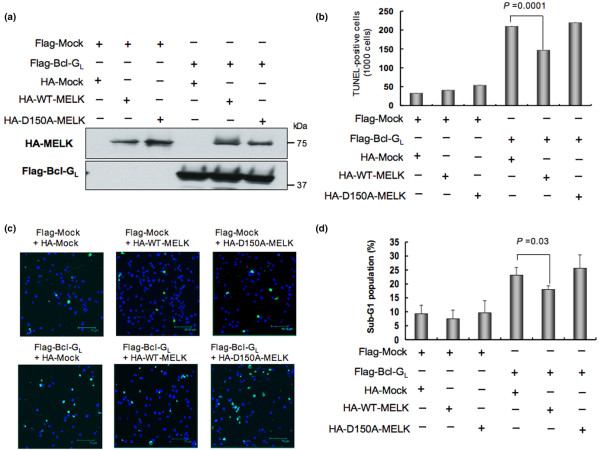
MELK involvement in the apoptosis cascade through Bcl-GL. HA (hemagglutinin)-tagged MELK (HA-wild-type (WT)-MELK or HA-kinase-dead (D150A)-MELK) and Flag-tagged Bcl-GL (Flag-Bcl-GL) expression vectors were co-transfected into COS7 cells for 24 hours. (a) The expression of MELK and Bcl-GL proteins in the co-transfected cells were examined by western blot analysis. (b) TUNEL assays after transfection with pCAGGSnHC (HA-Mock), pCAGGSn3FH (Flag-Mock), HA-tagged MELK (WT and D150A), Flag-tagged Bcl-GL expression vectors, and combinations of these. Apoptotic cells were measured by counting of TUNEL staining (means ± standard deviation, n = 3; P = 0.0001; unpaired t-test). (c) Representative images of TUNEL assays. Cells were labeled with DAPI (4',6-diamidino-2-phenylindole) for counting of total cell number. Apoptotic cells with DNA strand breaks were labeled with green fluorescence. (d) FACS analysis of cells collected after transfection with pCAGGSnHC (HA-Mock), pCAGGSn3FH (Flag-Mock), HA-tagged MELK (WT and D150A), Flag-tagged Bcl-GL expression vectors, and combinations of these. Proportions of apoptotic cells are indicated as percentages of sub-G1 populations. Each value represents the average of three experiments (means ± standard deviation, n = 3).